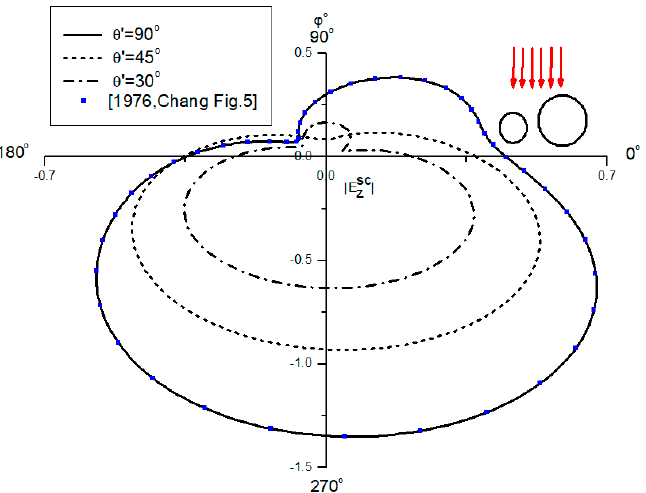
Figure 3. The far electric field pattern (in polar coordinates) for the inset structure, arising from that of Figure 1 when L = 3, D 23 = 0.4 λ 0 , ε 1 = ε 2 = ε 4 = ε 0 , α 3 = 0.1 λ 0 , α 5 = 0.2 λ 0 , ε 3 = ε 5 = 2 ε 0 , = µ µ σ i = 0 ( i = 1,2,3,4,5 ) , while E 0 = 1, H 0 = 0, ϕ (cid:48) = 90 ◦ and θ (cid:48) = 30 ◦ , 45 ◦ , 90 ◦ i 0 and